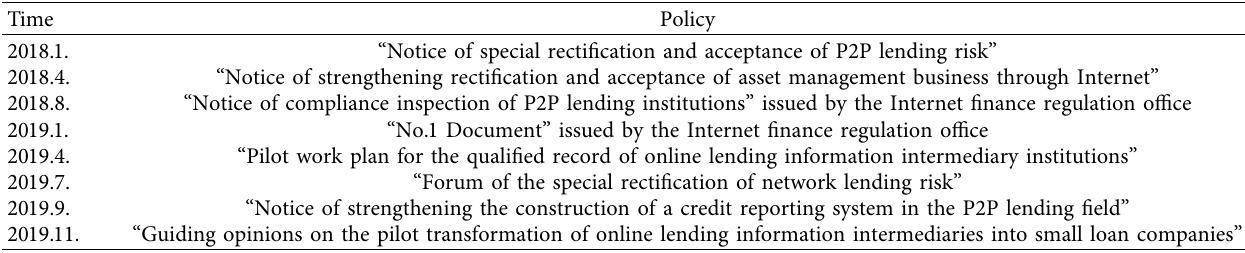
Table 2: The policy of online lending in 2018 and 2019.